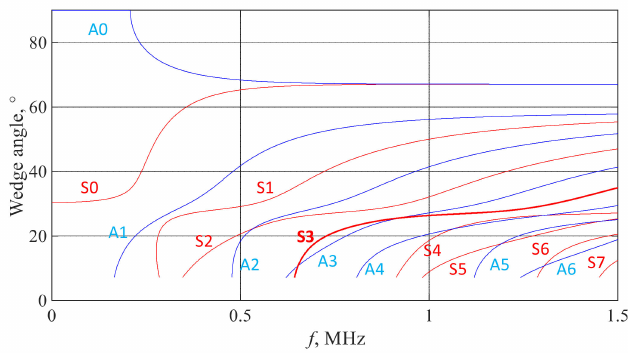
Figure 15. Excitation angle of the specific wave mode using plexiglass